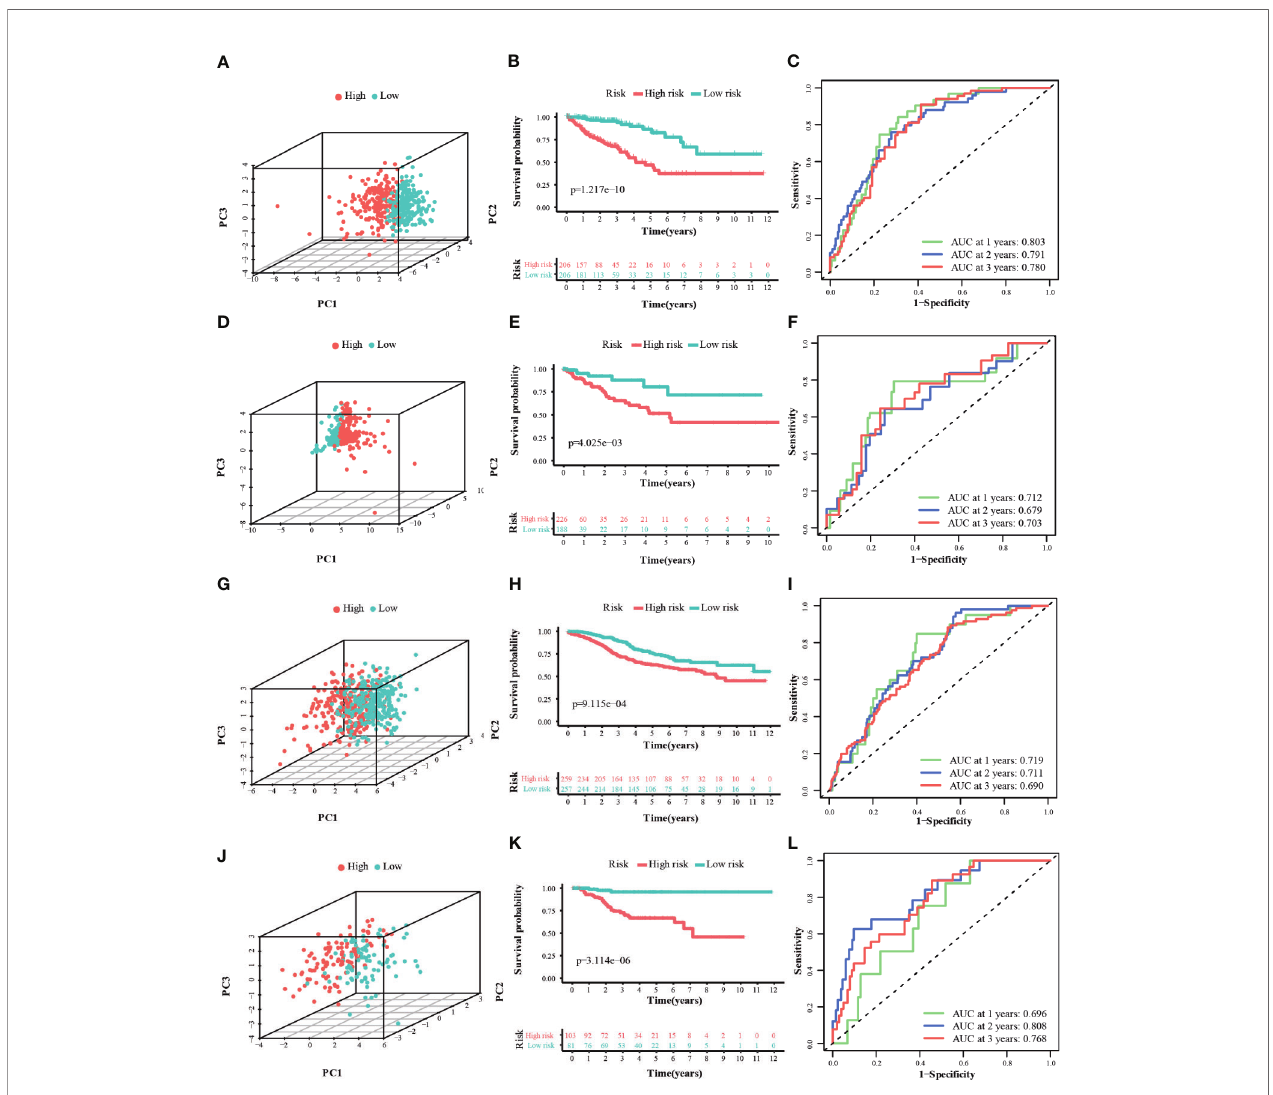
FIGURE 5 | 3dPCA plots of the TCGA (A) , ICGC (D) , GSE14333 (G) and GSE39582 (J) datasets. Kaplan-Meier curves for the OS of patients in the high-risk group and low-risk group in the TCGA (B) , ICGC (E) , GSE14333 (H) and GSE39582 (K) datasets. AUC of time-dependent ROC curves for the risk score in the TCGA (C) , ICGC (F) , GSE14333 (I) and GSE39582 (L)